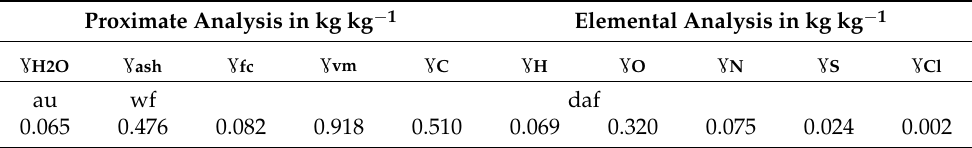
Table 1. Sewage sludge proximate and elemental analysis; au: as used (raw), daf: dry ash free, wf: water free, fc: fixed carbon, vm: volatile matter.